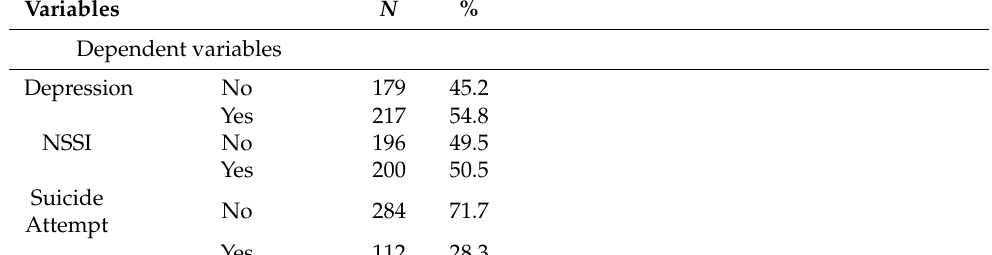
Table 1. Descriptive Statistics for Participants and Key